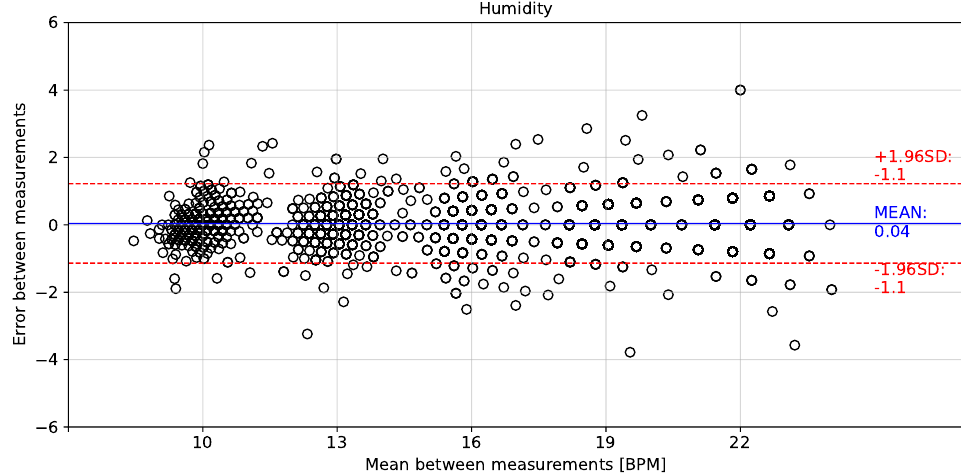
Figure 14. Bland–Altman plot for instantaneous breathing rate using relative humidity signal com- pared to airflow signal.